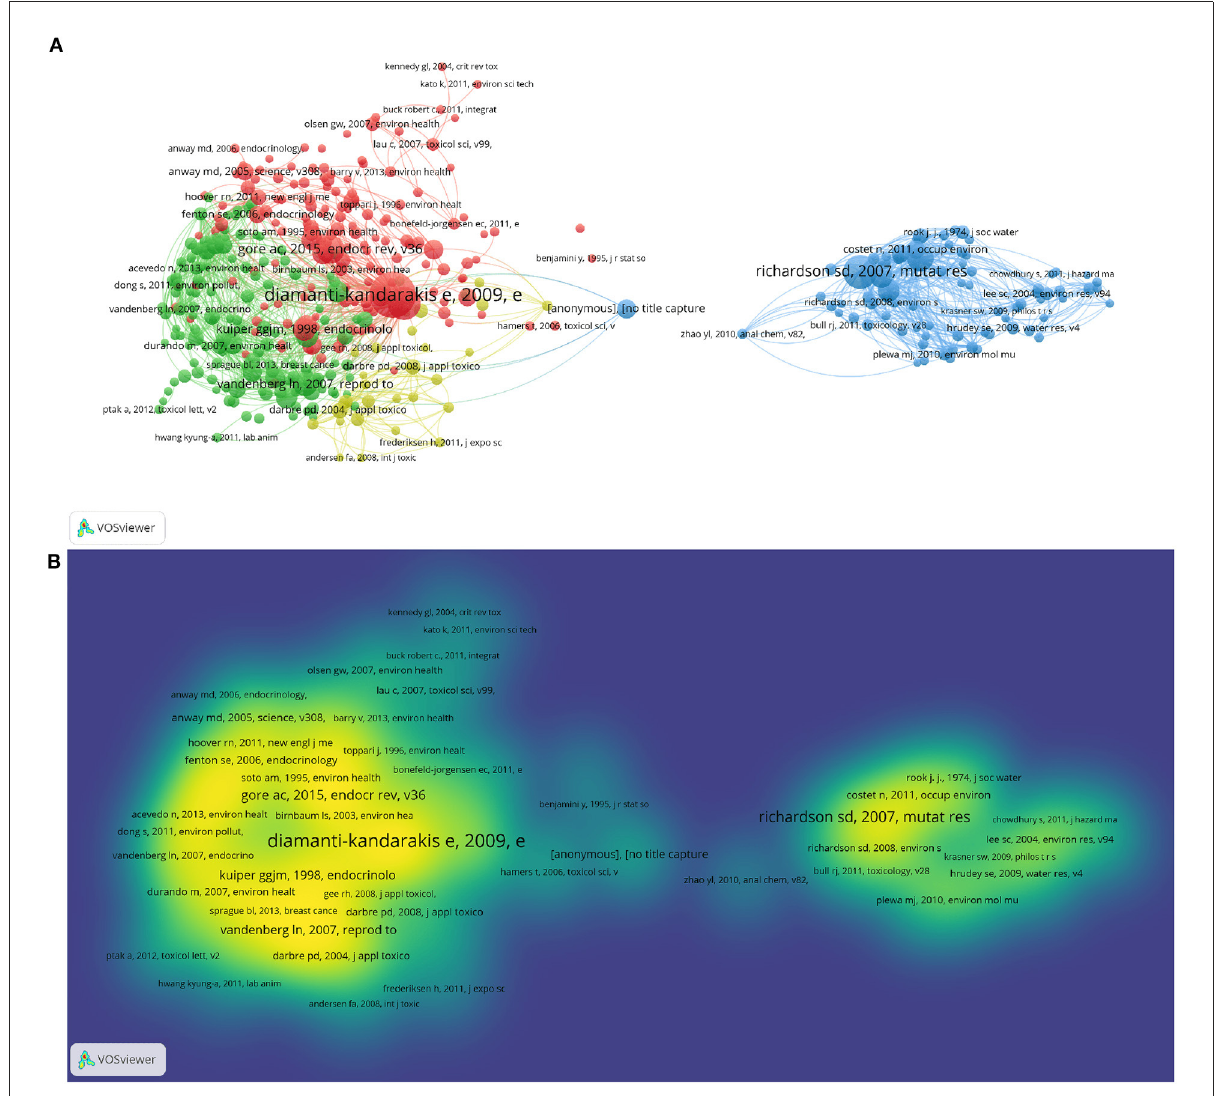
FIGURE3 The network map of co-citation between references with 20 or more 20 citations. (A) The network visualization map of co-citation between references with 20 or more 20 citations. (B) The density visualization map of co-citation between references with 20 or more 20 citations. The degree of color is proportional to the number of co-citations (green: low citations; yellow: high